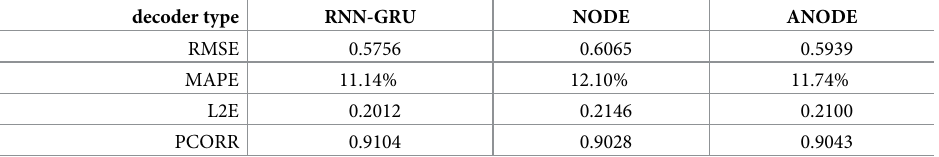
Table 1. Four performance metrics for one-week-ahead predictions obtained by using the Seq2Seq models with RNN-GRU decoder, NODE decoder, and ANODE decoder. The results of the best performing hyperparameters are